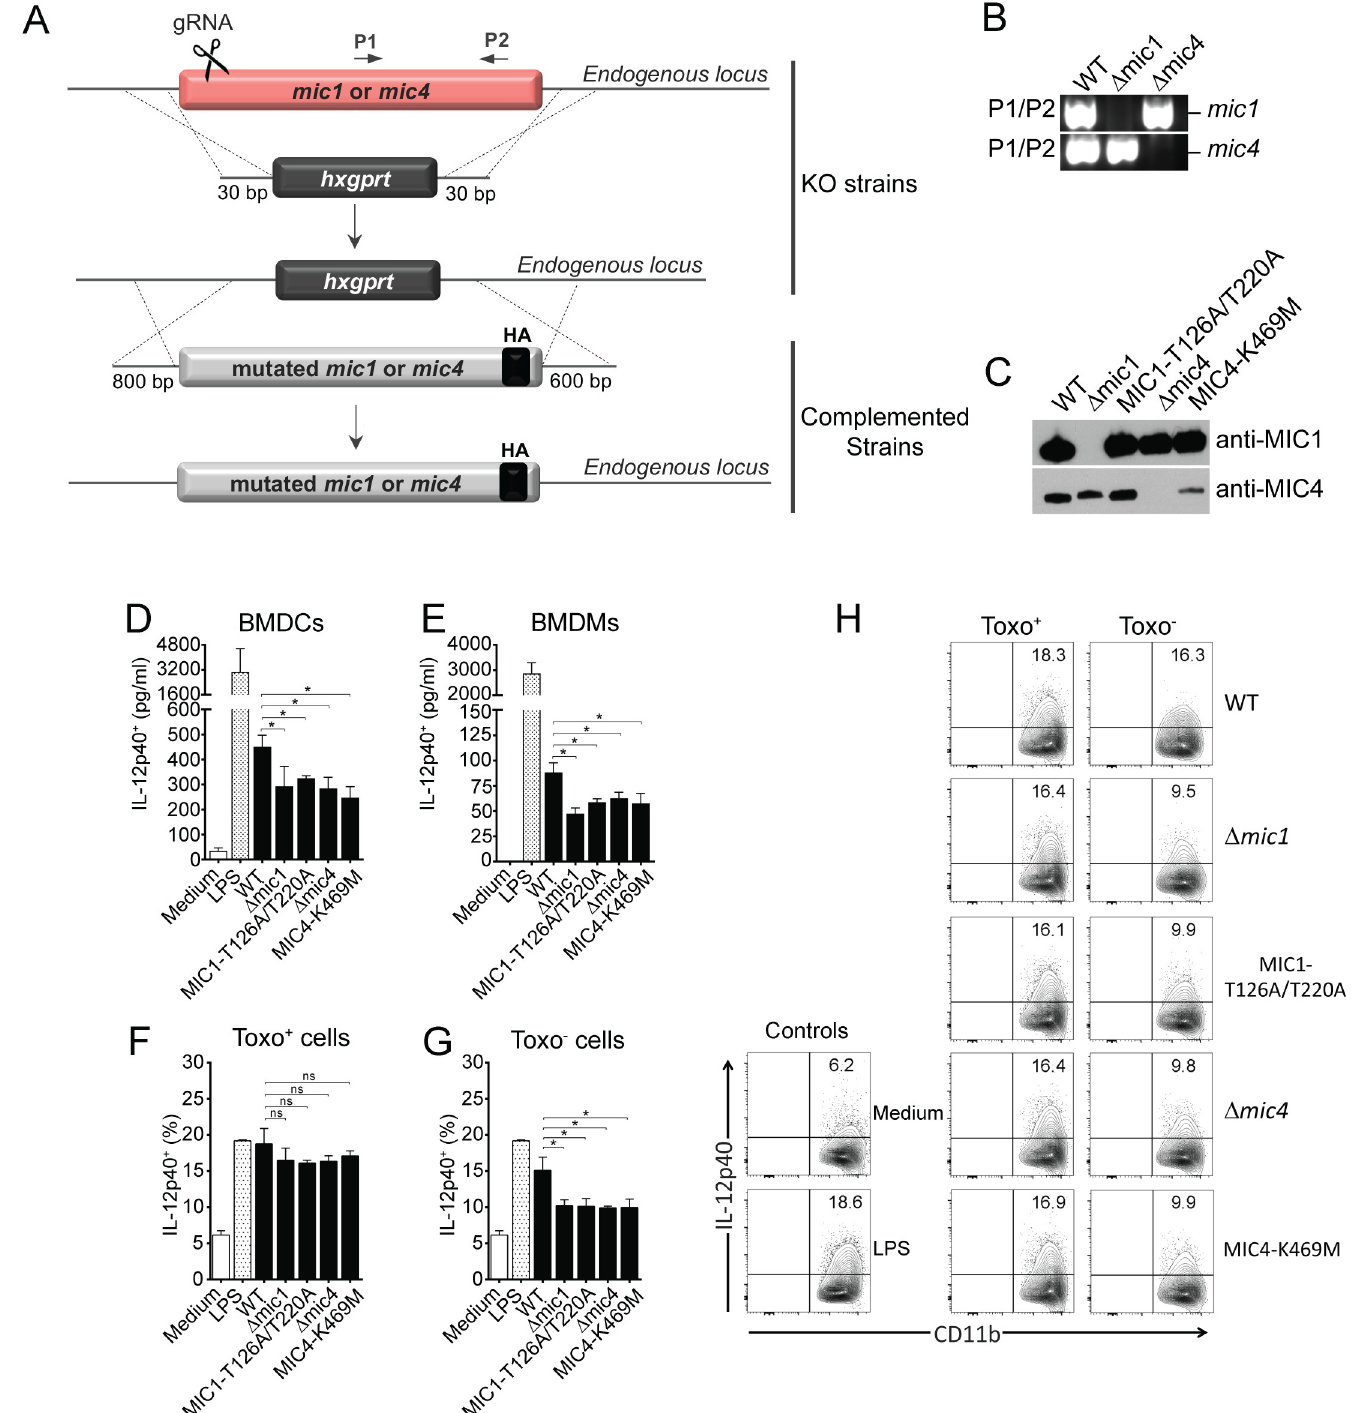
Fig 5. The IL-12 production during T . gondii in vitro infection partially depends on MICs and their ability to recognize carbohydrates on APCs surface. (A) Schematic representation of knockout and complementation constructs for MIC1 and MIC4 loci. The endogenous loci were disrupted using the hypoxanthine- xanthine-guanine phosphoribosyl transferase (HPT)-selectable marker and CRISPR methodology. (B) PCR analysis for MIC1 and MIC4 loci of gDNA from parental (WT RH- Δ ku80 / Δ hpt -GFP/Luc) and knockout (RH- Δ ku80 / Δ mic1 -GFP/Luc and RH- Δ ku80 / Δ mic4 -GFP/Luc) strains. (C) Western blot analysis of an equal loading of whole cell lysates corresponding to 3 Δ 10 6 tachyzoites (1 x 10 8 /mL) from WT, Δ mic1 , Δ mic1 ::MIC1-T126A/T220A, Δ mic4 and Δ mic4 ::K469M parasites. The membrane was probed with anti-MIC1 (IgY, 1:20,000) and anti-MIC4 (IgY, 1:8,000). (D) Bone marrow-derived dendritic cells (BMDCs) and (E) Bone marrow-